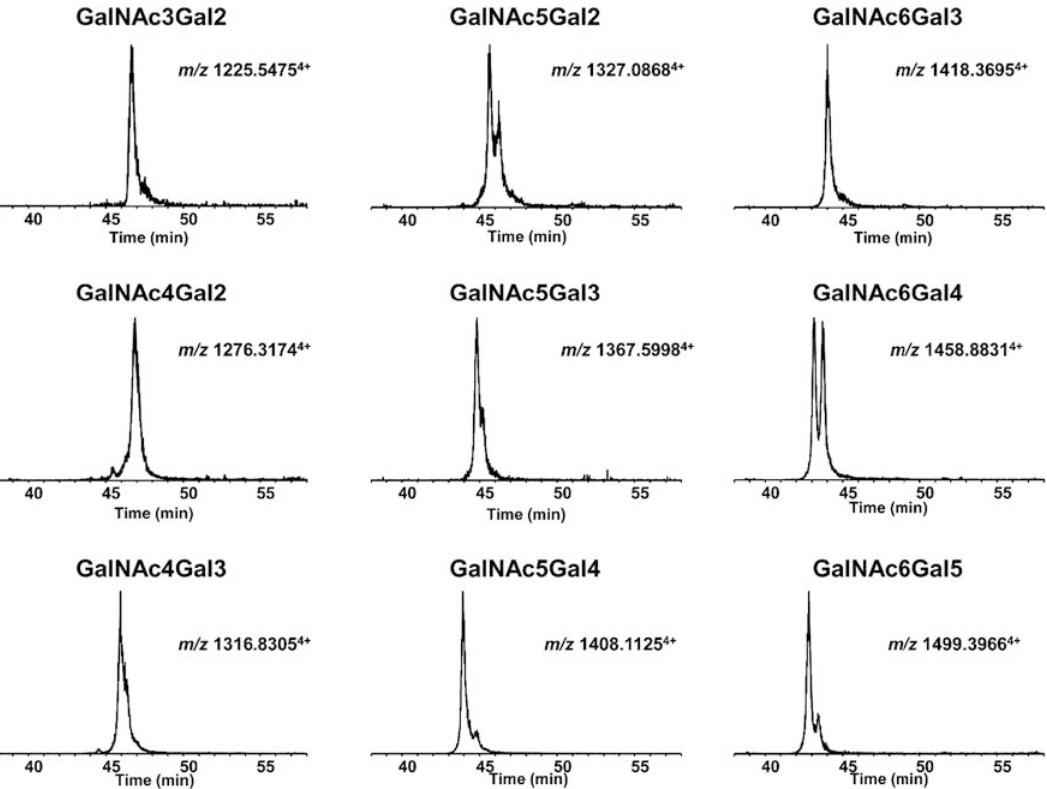
Figure 3 Extracted ion chromatogram (XIC) of IgA1 hinge region (HR) O -glycoforms containing Gal-deficient O -glycans. The ion chromatogram for each glycopeptide ion was individually extracted for the specific m/z of each glycopeptide ion species for identification of structural isomers based on alternative glycan-attachment sites in the backbone amino acid